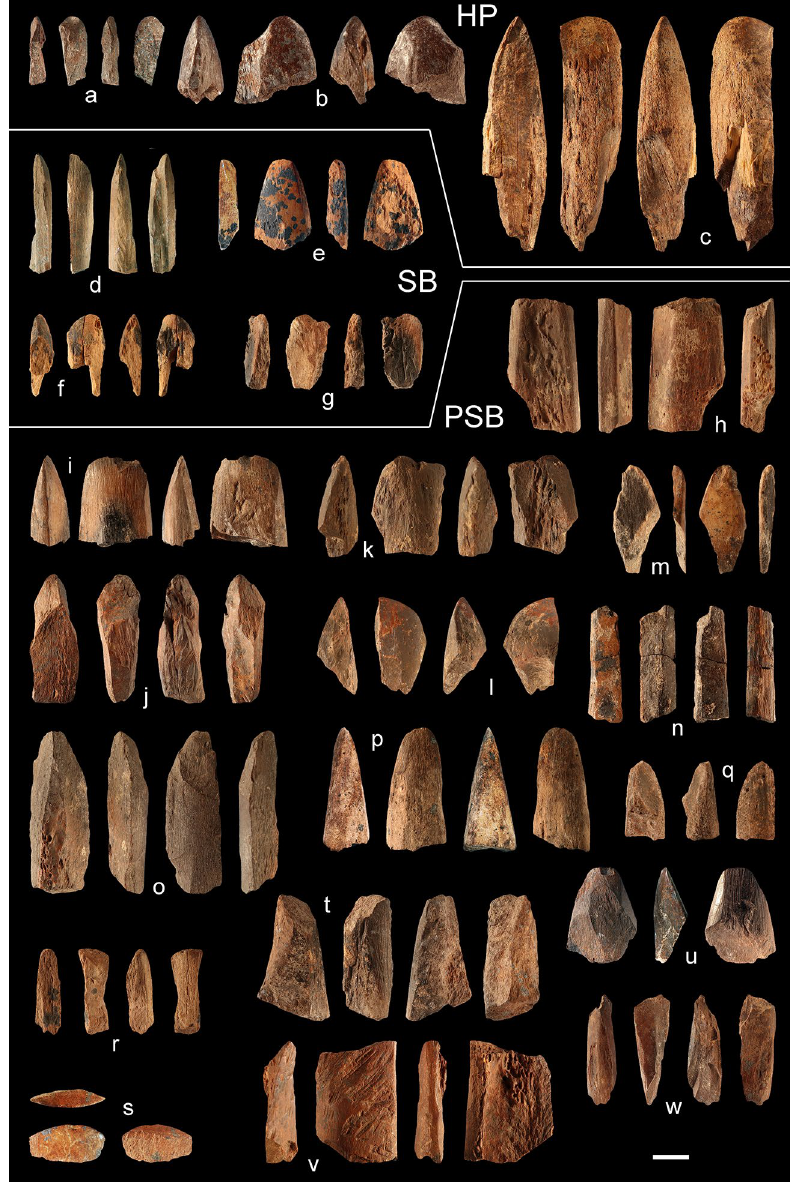
Figure 2. Double-beveled bone tools from Sibudu. The tools were found in Howiesons Poort ( a – c ), Still Bay ( d – g ) and pre-Still Bay ( h – w ) layers. See Table 1 for contextual information, Table S1–S4 for zooarchaeological, morphometric, taphonomic, technological, use-wear, and tip morphometry data. Scale = 1 cm. Photographs by